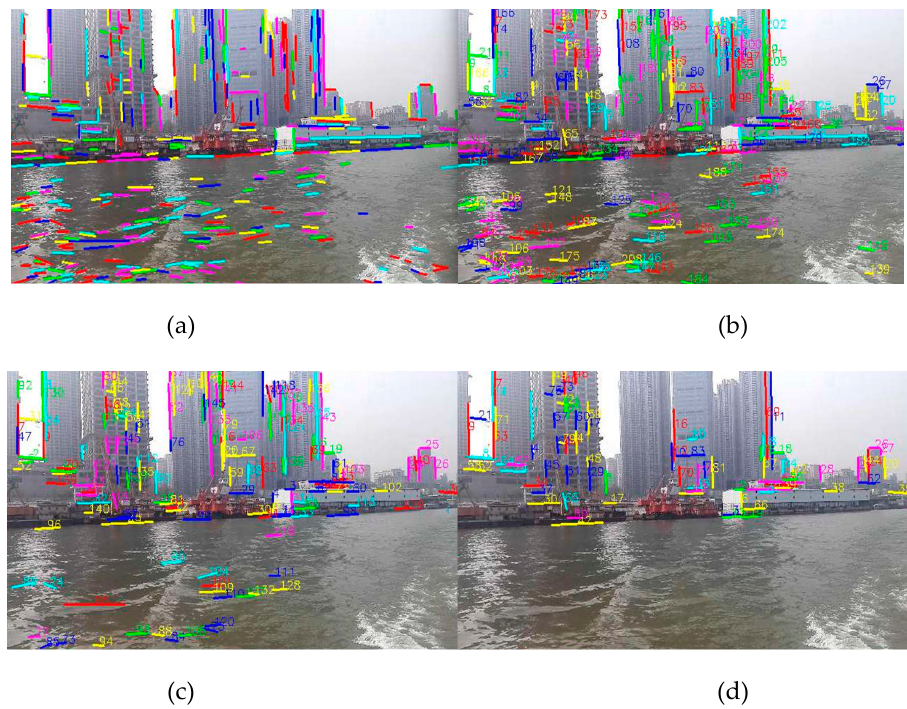
Figure 4. The results of line segment extraction and matching: ( a ) line segment extraction of the first frame image; ( b ) the line segment matching result of the first frame and the second frame image; ( c ) the result of line segment matching with the third frame on the basis of Figure 4b; ( d ) the result of line segment matching that repeats until the 10th frame. Sensors 2020 , 20 , x FOR PEER REVIEW